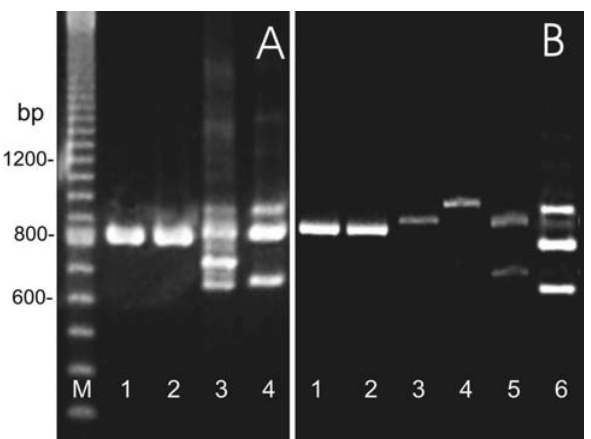
Figure 1 - Amplification products generated by rDNA-PCR. A. lane 1 = P. aeruginosa PA01, lane 2 = P. aeruginosa ATCC 9027, lane 3 = P. putida ATCC 15175 and lane 4 = P. fluorescens ATCC 13525. B. Refer- ence strains: lane 1 = P. aeruginosa PA01, lane 2 = isolate 22 rDNA pat- tern 1, lanes 3 to 6 one representative of the other four rDNA-PCR patterns produced by automated identified P. aeruginosa isolates. Lane M = 100 bp ladder.